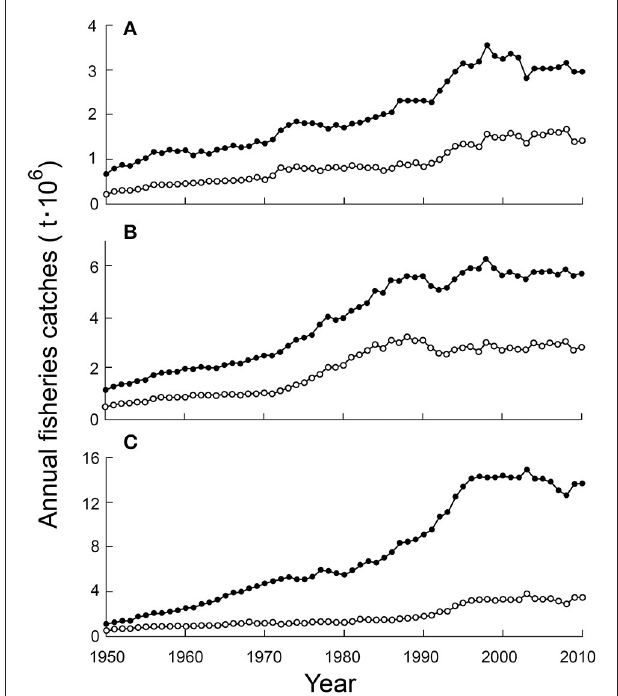
FIGURE 2 | Fisheries catches from the Yellow (A) , East China (B) , and South China Seas (C) ; black dots: total reconstructed catch (from www. seaaroundus.org); white dots: catch reported by species (about half for the Yellow and East China Seas, and less than one third for the South China Sea).